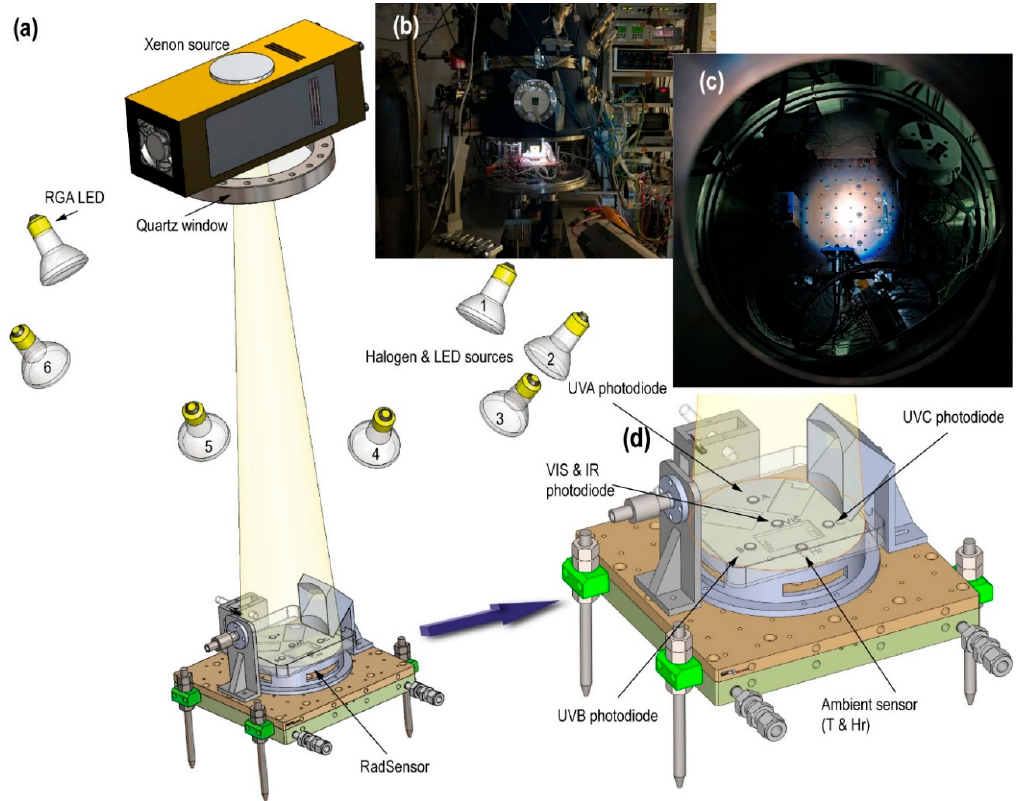
Figure 8. ( a ) Technical illustration of the radiation sources. ( b ) Photograph of MARTE with the lower cover open. The RadSensor is illuminated with the Xenon source. ( c ) Photograph of the sample holder illuminated from the top cover of MARTE. The light comes from the Xenon source. ( d ) Technical close-up of the RadSensor for UV radiation characterization.